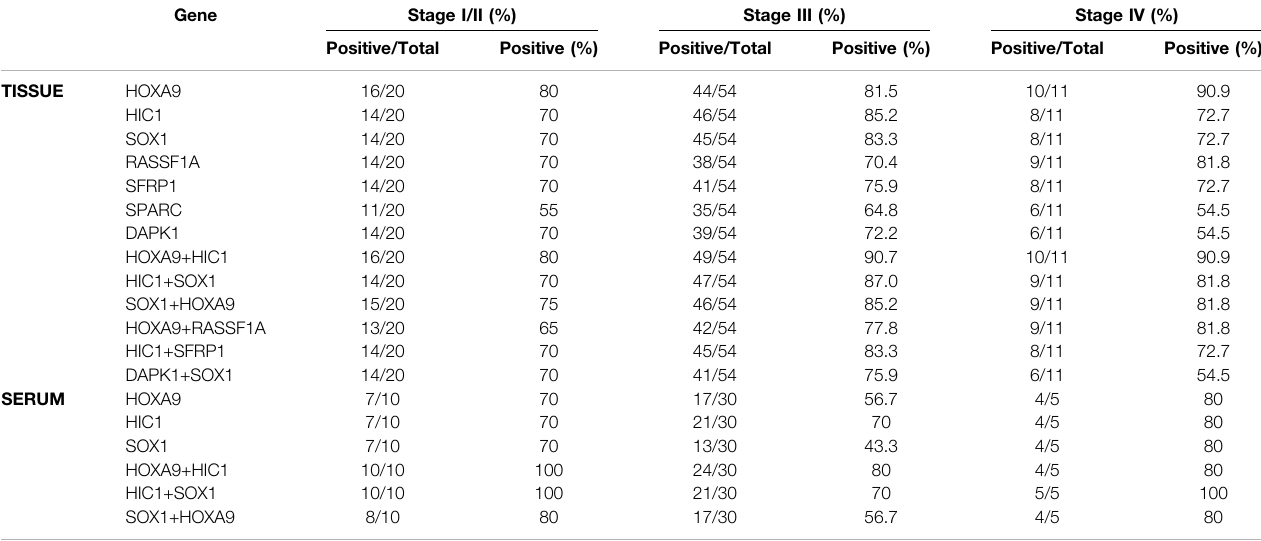
TABLE 3 | Methylation frequency of candidate gene and two-gene marker panels in different stages of epithelial ovarian carcinoma. Gene Stage I/II